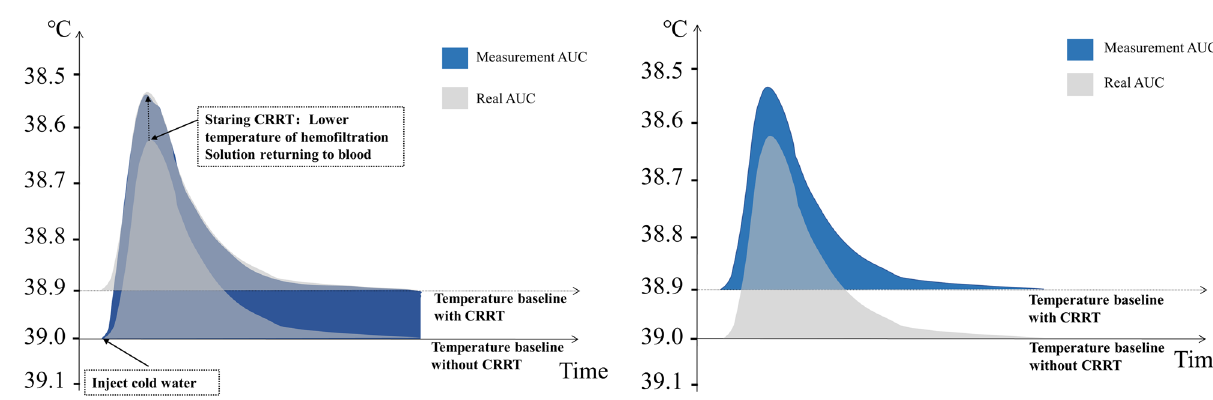
Figure A3: Changes of the AUC detected by PICCO at T2 and T4. The measured AUC was the same as the real AUC.